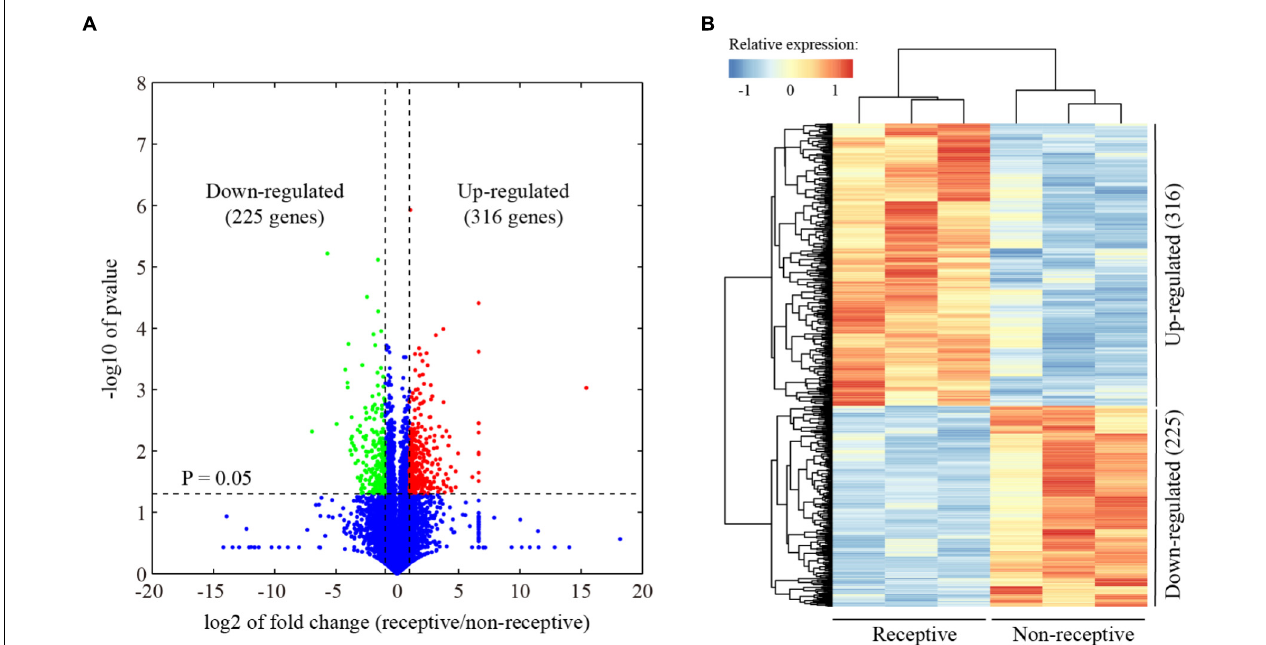
FIGURE 1 | Identification of differentially expressed genes associated with endometrial receptivity. (A) Volcano plot for the comparison between the receptive endometrium (day 4 of pregnancy) and pre-receptive endometrium (day 3 of pregnancy) in mice. The cutoff values fold change > 2 and FDR < 0.01 were utilized to identify differentially expressed genes. Non-changed genes were shown in blue color. Red color is indicative of up-regulated genes and green is indicative of down-regulated genes. (B) Heatmap plot of differentially expressed genes. The Pearson correlation distance metric and the average linkage clustering algorithm were